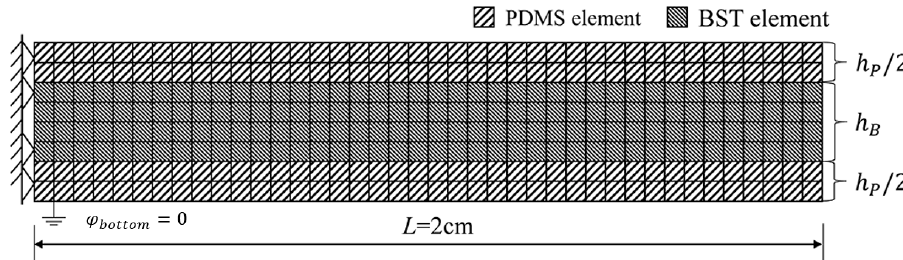
Figure 2. Finite element diagram of micro scale flexoelectric laminated beam.